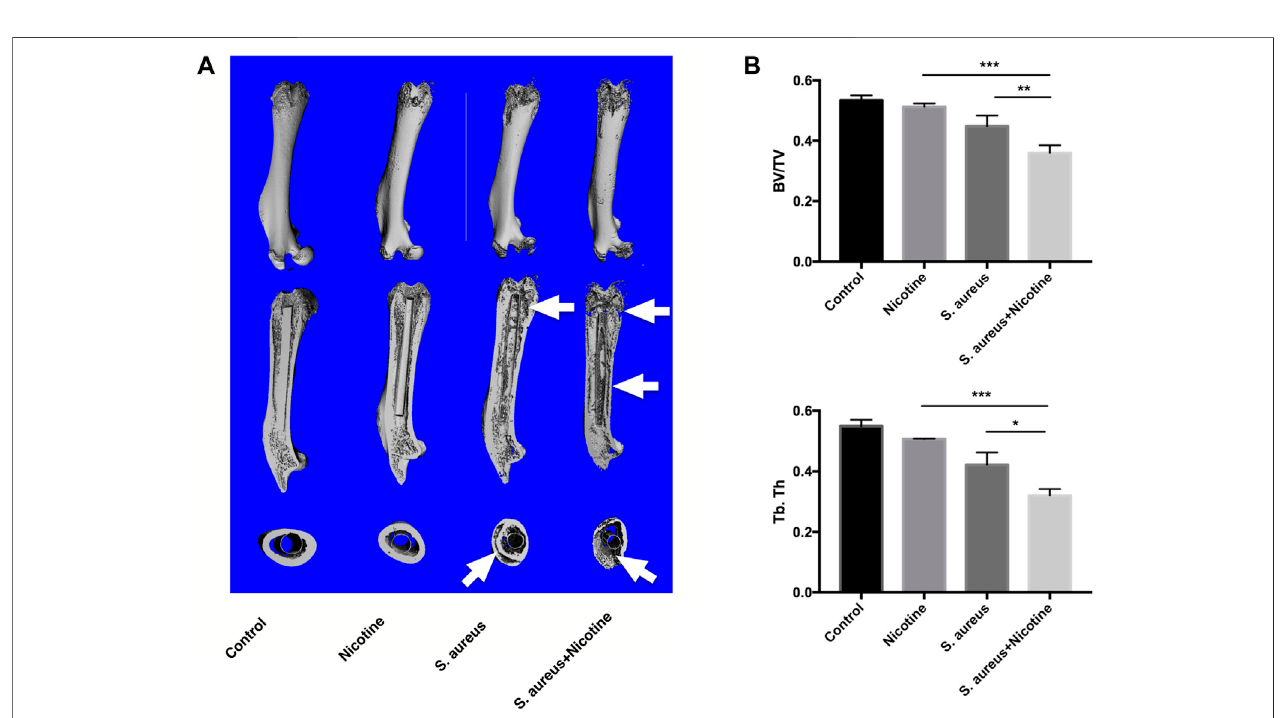
FIGURE 3 | Nicotine and S. aureus synergistically promoted the bone resorption. (A) 3D micro-CT images of rat femurs at three weeks after surgery. Osteolytic lesions and cortical bone destruction are pointed out by white arrows. (B) BV/TV and Tb.Th of the selected regions evaluated by micro-CT. * p < 0.05. ** p < 0.01. *** p <